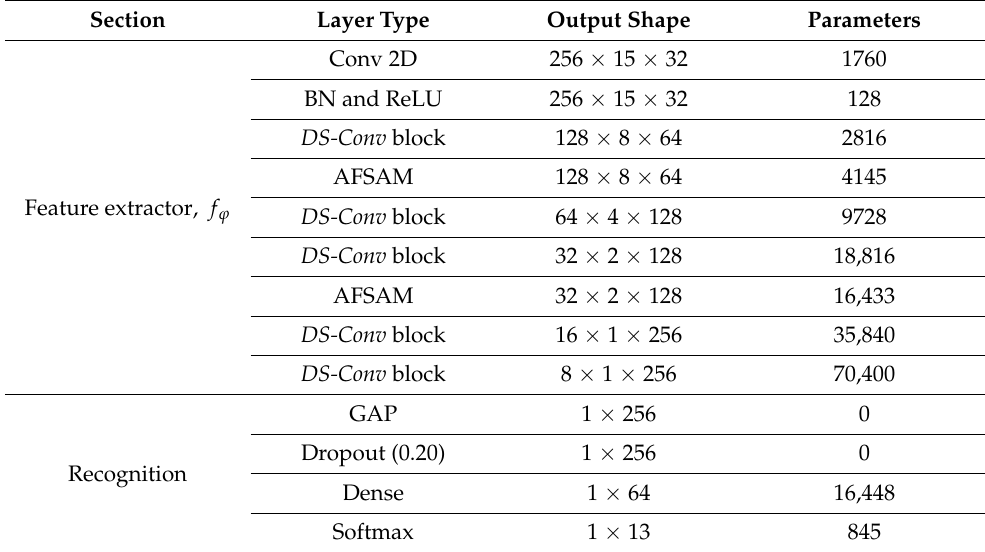
Table 2. Summary of the HHI-AttentionNet